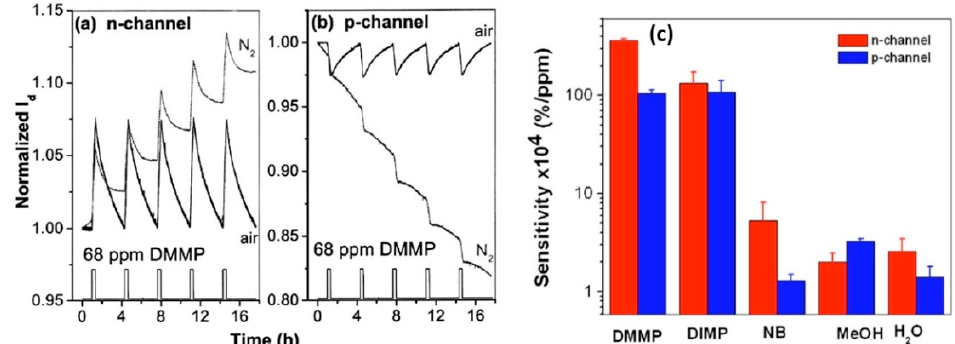
Figure 7. ( a ) Chemical responses of n-channel CuPcF 16 ( a ) and p-channel CuPc ( b ) ChemFETs to DMMP in air and N 2 at 25 ◦ C. ( c ) The sensitivities of n- and p-channel ChemFETs to nerve agent simulants (DMMP and DIMP) and other analytes: MeOH, H 2 O, and NB at 25 ◦ C. The sensitivity is in logarithmic scale. Reprinted from [69] with permission from AIP Publishing.